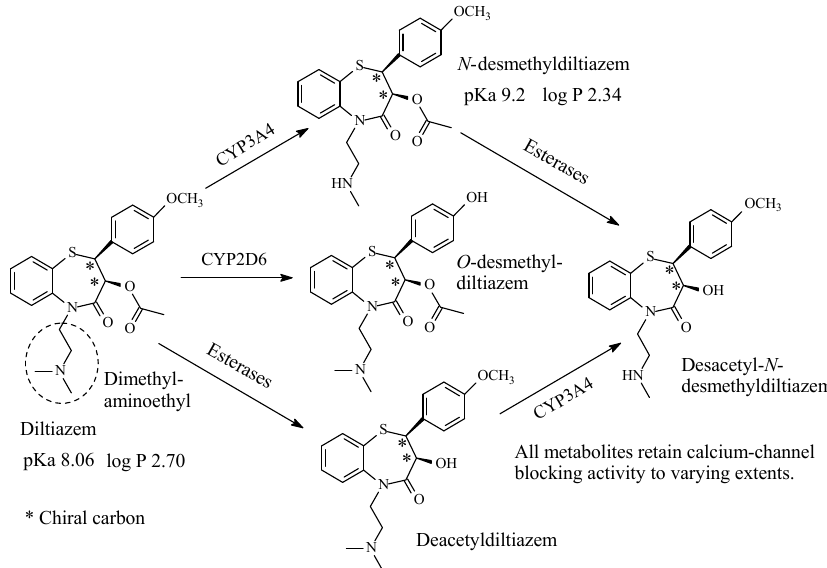
Figure 30. Metabolic pathways of diltiazem.